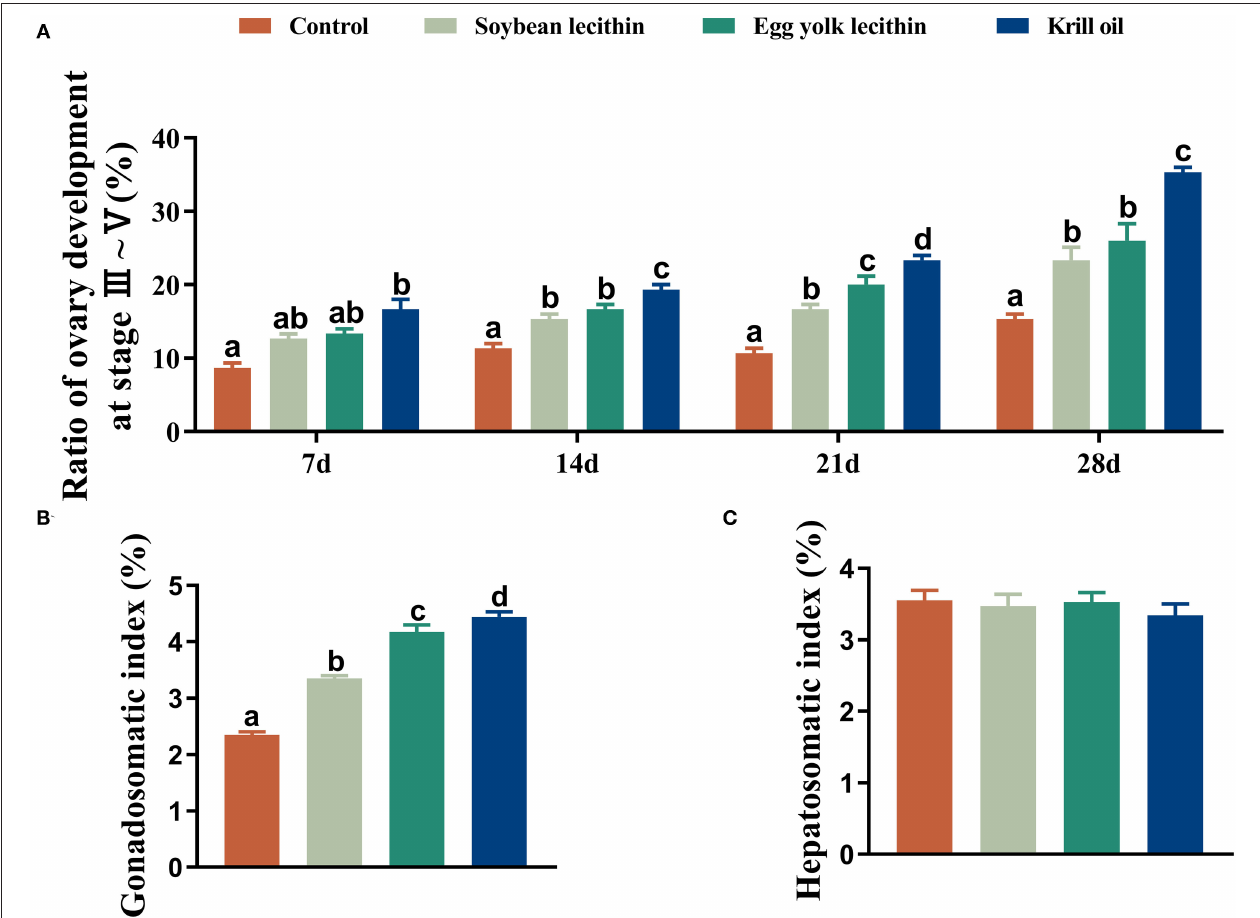
FIGURE 2 | Phenotypic parameters of gonadal development of female L. vannamei fed with different experimental diets. (A) The proportion of ovarian development from phase 3 to phase 5 at different times. (B) Gonadosomatic index. (C) Hepatosomatic index. The values are the mean ± standard errors ( n = 4). Bars with different superscripts are significantly different ( p < 0.05, single factor analysis of variance and Duncan’s tests).